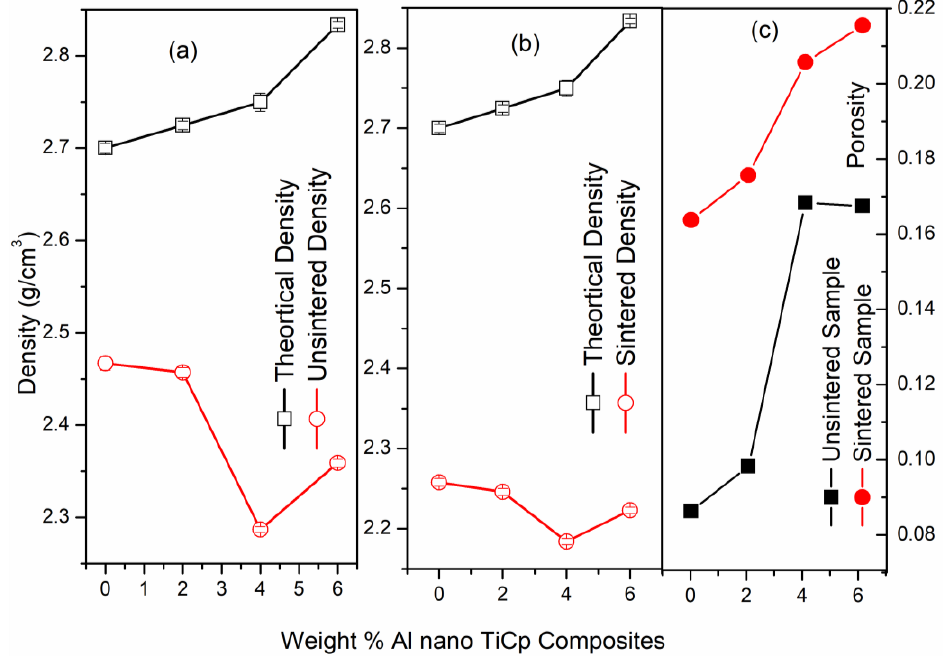
Figure 5. ( a ) Density of un-sintered, ( b ) Density of sinteredAl nanoTiC p Composites and ( c ) Porosity of Al nanoTiC p Composites in sintered and un-sintered conditions.